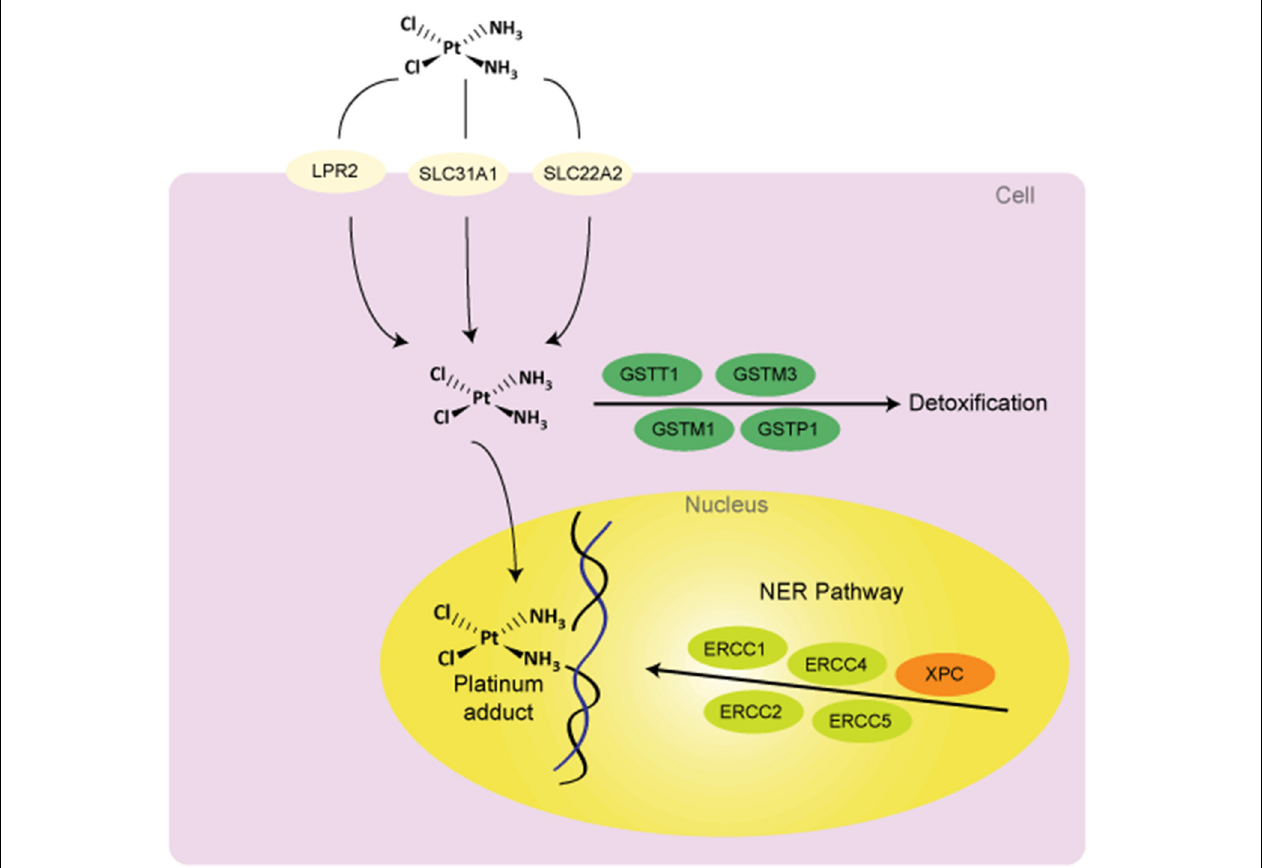
FIGURE 1 | Potential sources of variability to clinical response to cisplatin treatment. Abbreviations: DNA, deoxyribonucleic acid; GSTs, glutathione S-Transferases; NER, nucleotide excision repair; LPR2, Low Phosphate Root2; SLC31A1 (CTR1), solute carrier family 31 (copper